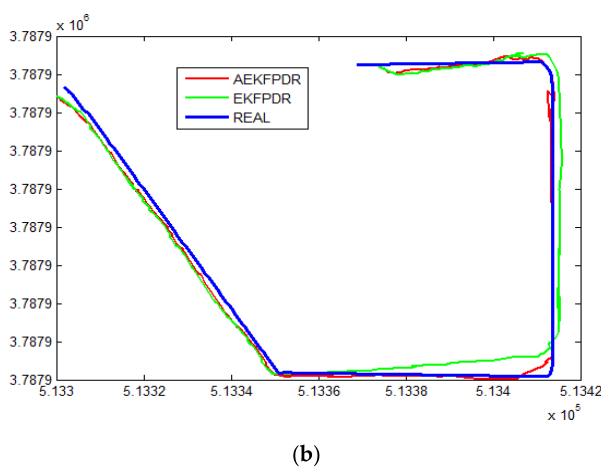
Figure 11. Trajectory analysis for different indoor positioning methods. ( a ) Trajectory of PDR, WIFI,REAL; ( b ) trajectory of AEKFPDR, EKFPDR.